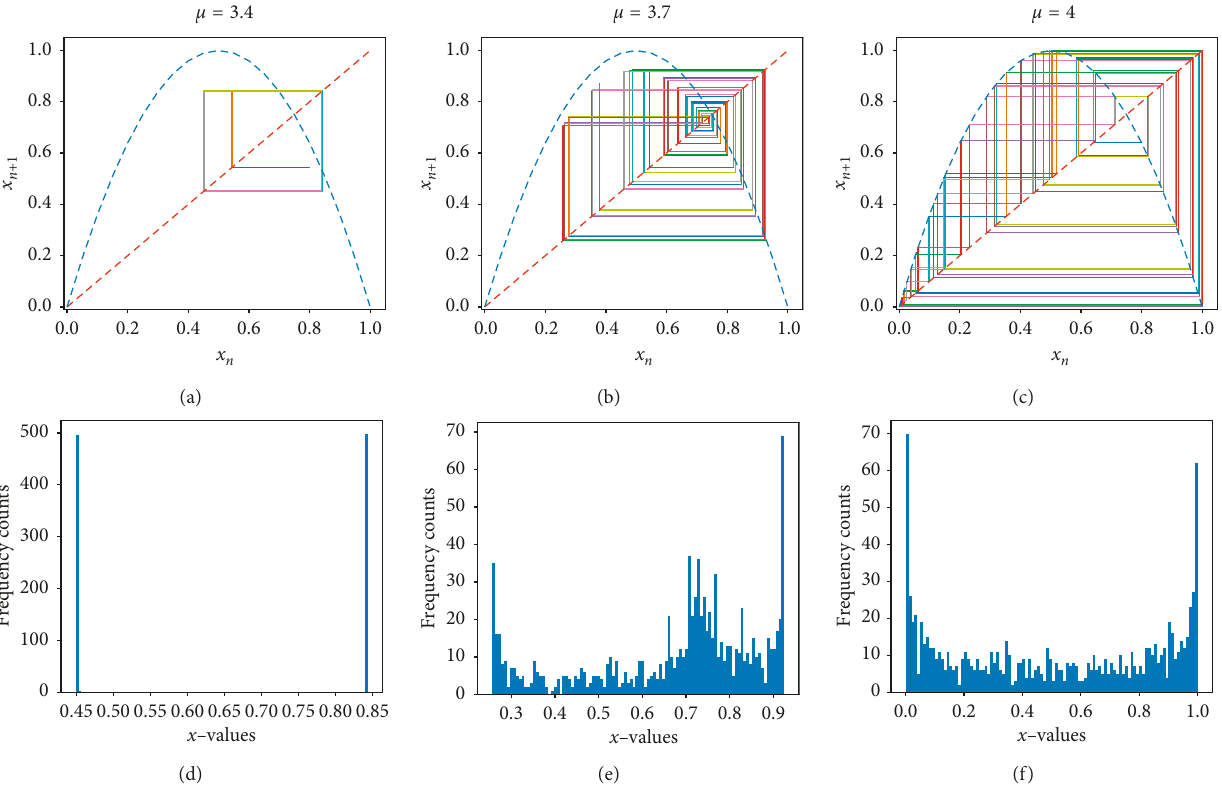
Figure 1: Graphic iterations and probability distributions for the logistic